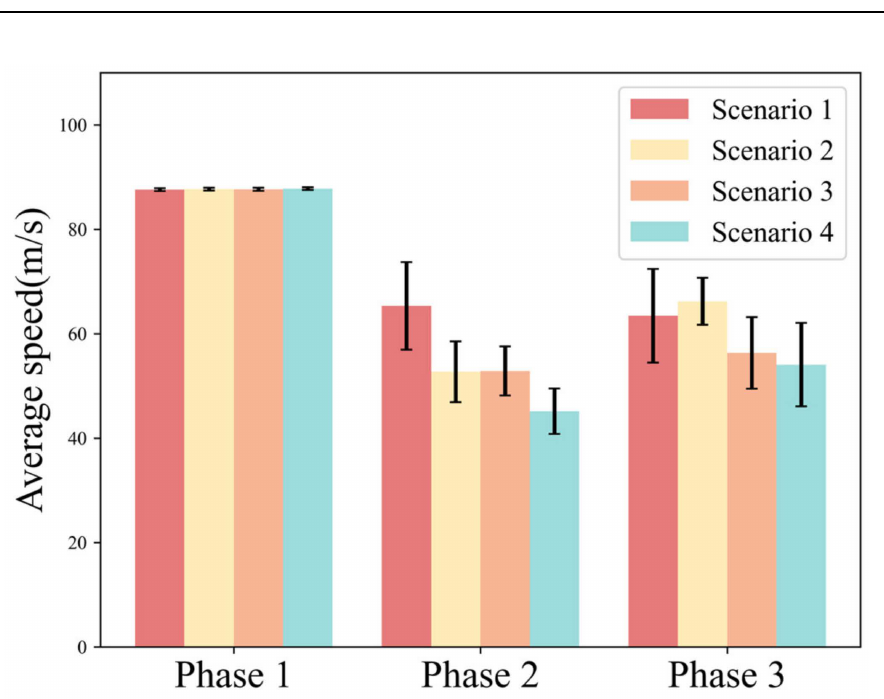
Figure 7. Variation pattern of average